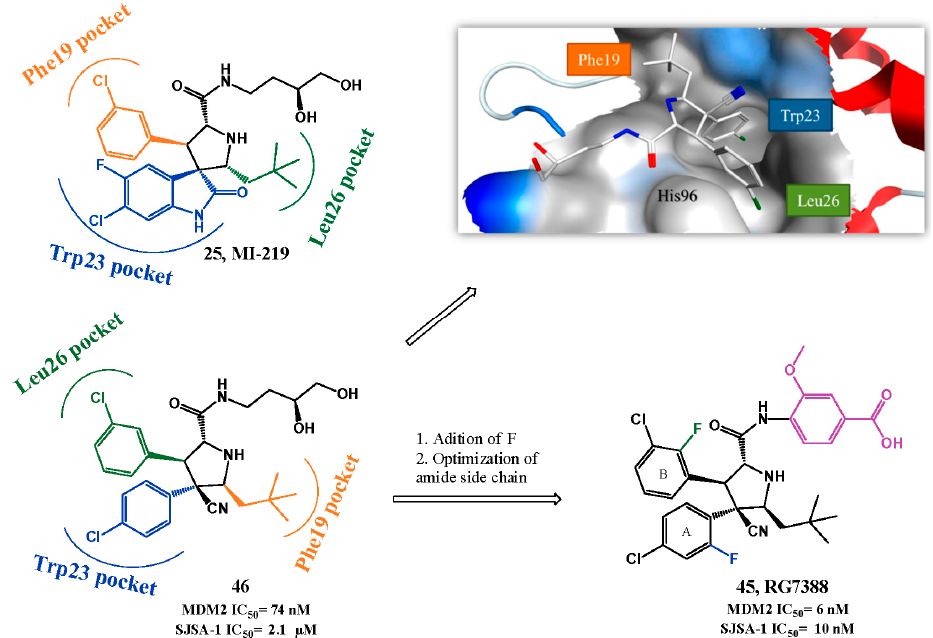
Figure 12. Pyrrolidine-2-carboxamide scaffold optimization. Right upper quadrant: crystal structure of compound 46 bound to MDM2 (PDB 4JRG). MDM2 surface is colored in blue for hydrophilic areas and grey for hydrophobic areas. Compound 46 is depicted in stick model and is colored according to element type: white for carbon atoms, blue for nitrogen atoms, red for oxygen atoms, and green for chlorine atoms.